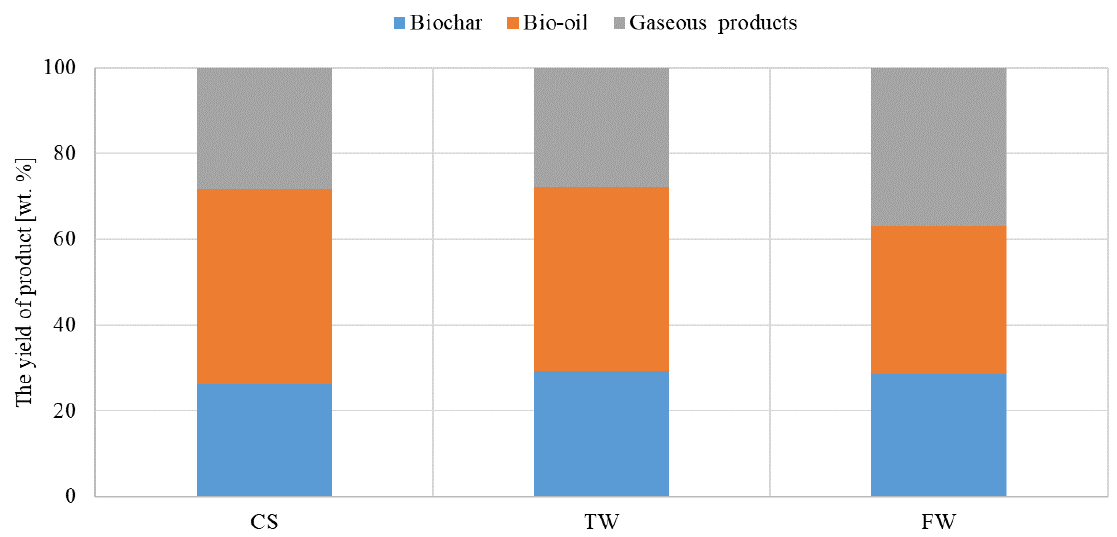
Figure 3. Yield distribution of waste biomass feedstocks (CS, TW, and FW) pyrolyzed at the same temperatures.